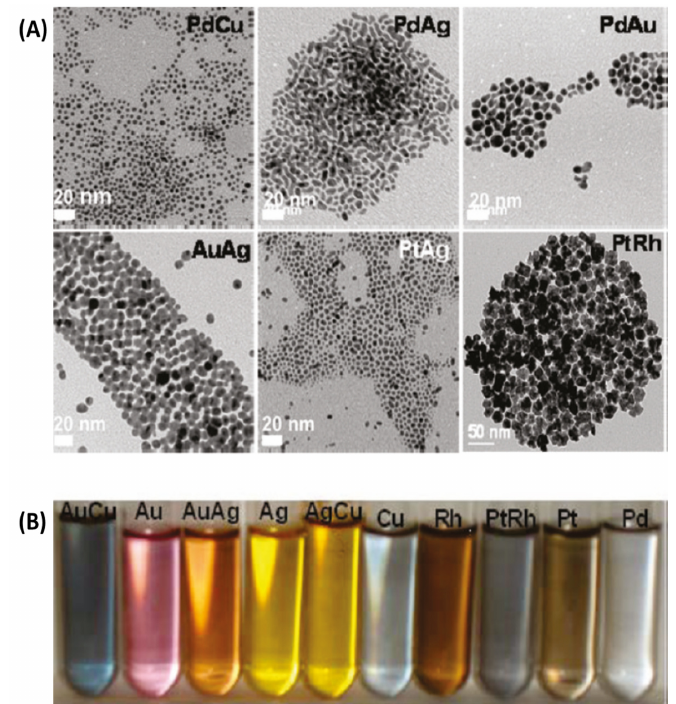
Figure 6. ( A ) TEM images of various bimetallic compositions under µwH and ( B ) digital images of bimetallic and corresponding monometallic NPs in toluene solution. Adapted with permission from the American Chemical Society. Copyright 2009 American Chemical